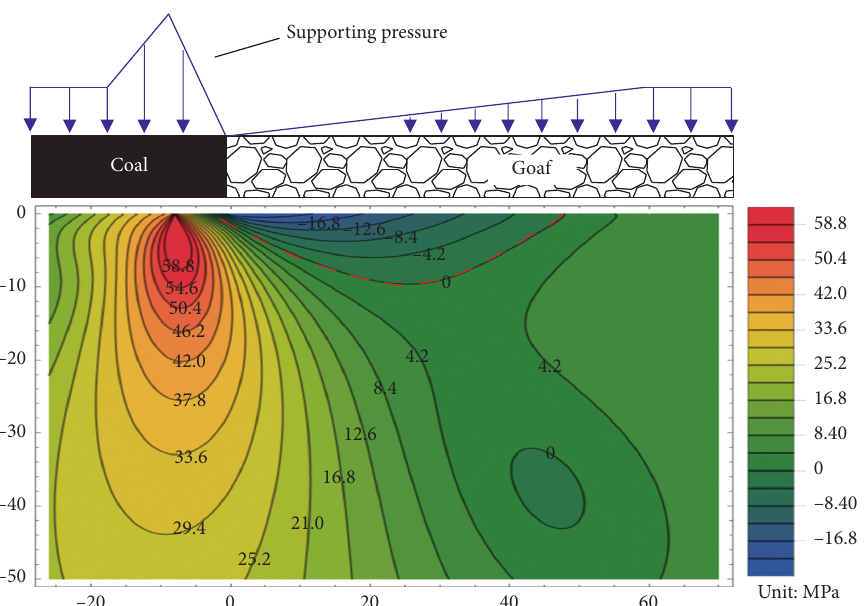
Figure 8: The theorical failure range of the